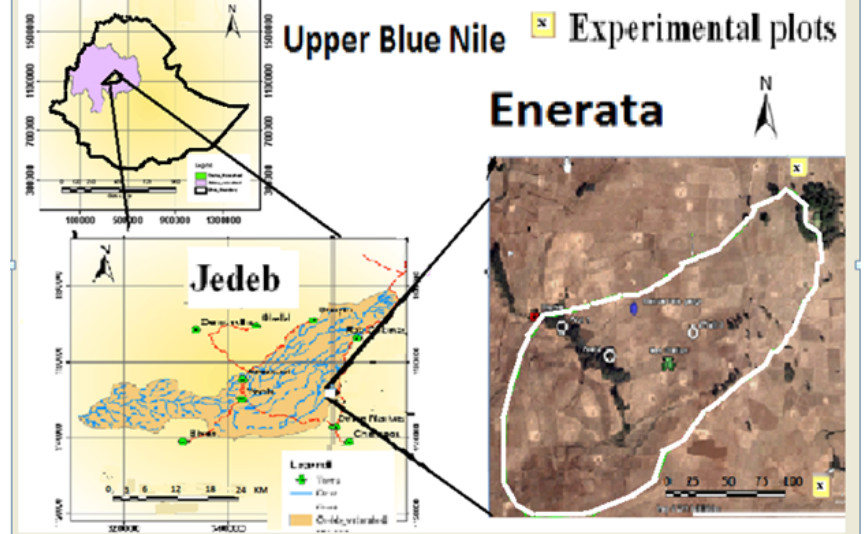
Fig. 1. Study sites at Enerata. Predominantly cultivated area in the mid-altitudes of the Choke Mountains, headwaters of the Blue Nile river basin. Source of Satellite picture is Google Earth